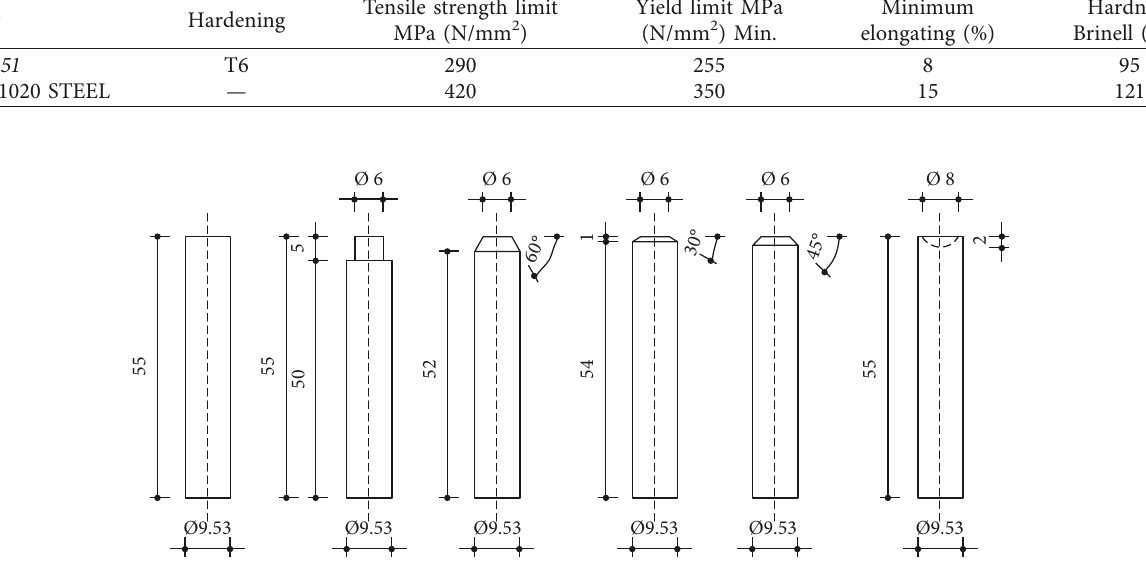
Figure 1: Variation of the initial geometry of the used contact point of the aluminum pins.